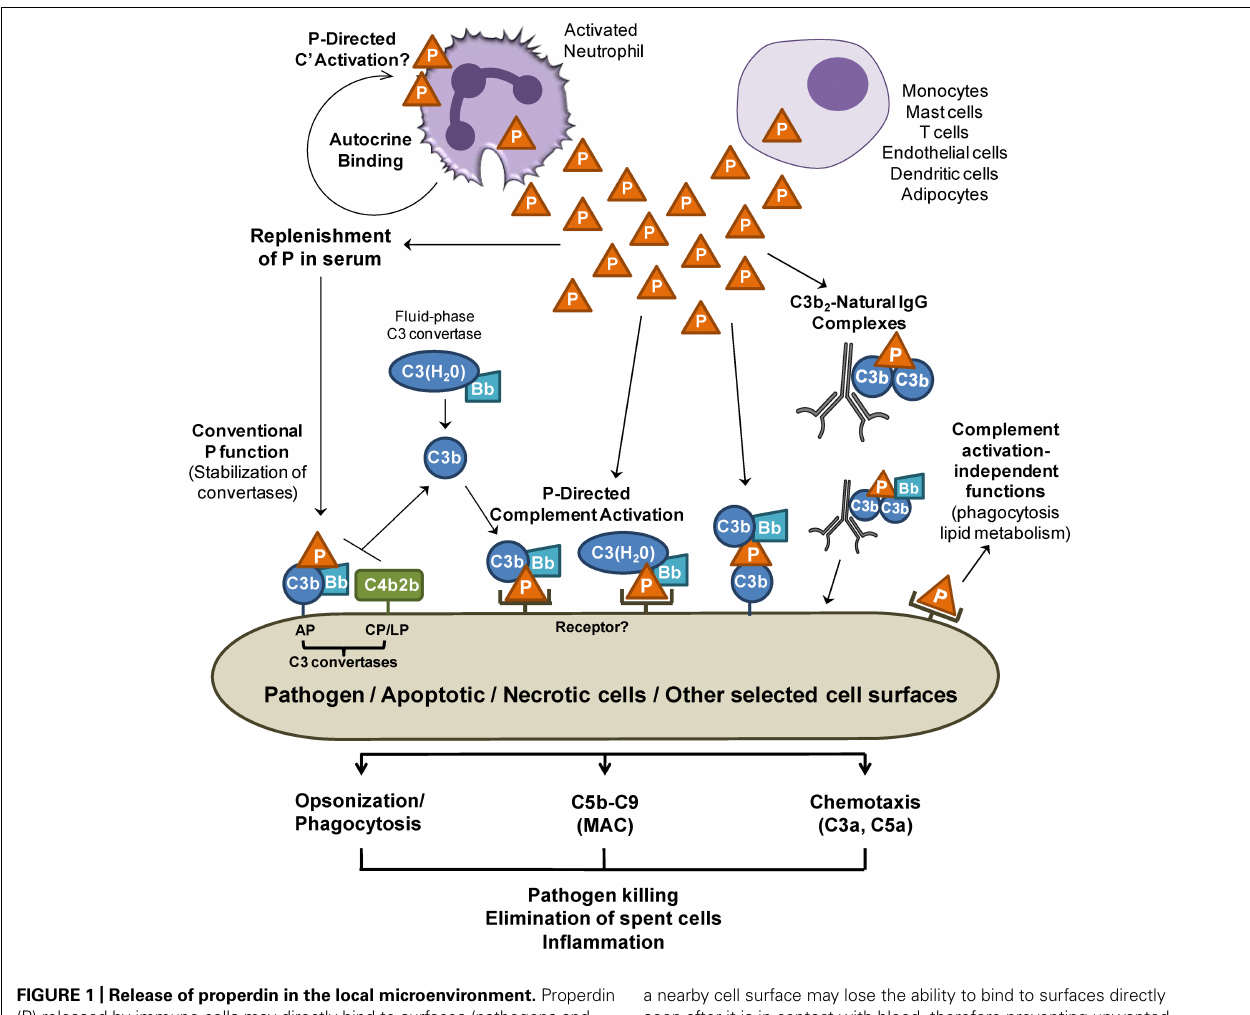
FIGURE 1 | Release of properdin in the local microenvironment. Properdin (P) released by immune cells may directly bind to surfaces (pathogens and cells) and promote AP complement activation. Properdin may recruit C3b or C3(H 2 O) to form a C3 convertase and further promote C3b deposition on surfaces (P-mediated complement activation). Sources of C3b may be derived from C3 convertases of the alternative pathway (AP), lectin (LP), or classical pathways (CP). C3(H 2 O) derived from “tick over” C3 hydrolysis may also bind to cell-bound properdin, forming a C3(H 2 O),Bb convertase on the cell. In addition, properdin can bind to C3b on surfaces and recruit additional C3b and factor B, generating new convertases. Properdin that does not encounter